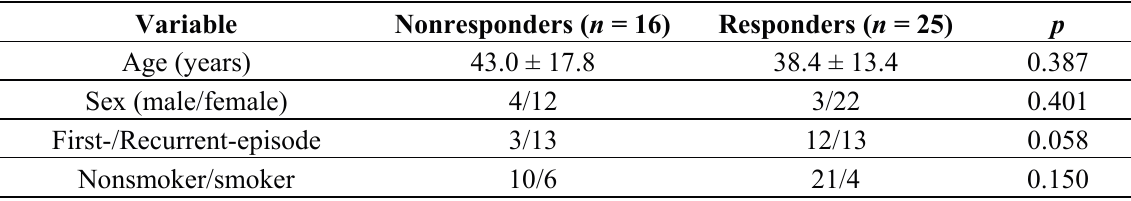
Table 2. Comparison of demographic data, clinical variables, and LDAEP between nonresponder and responder groups among major depressive disorder (MDD)